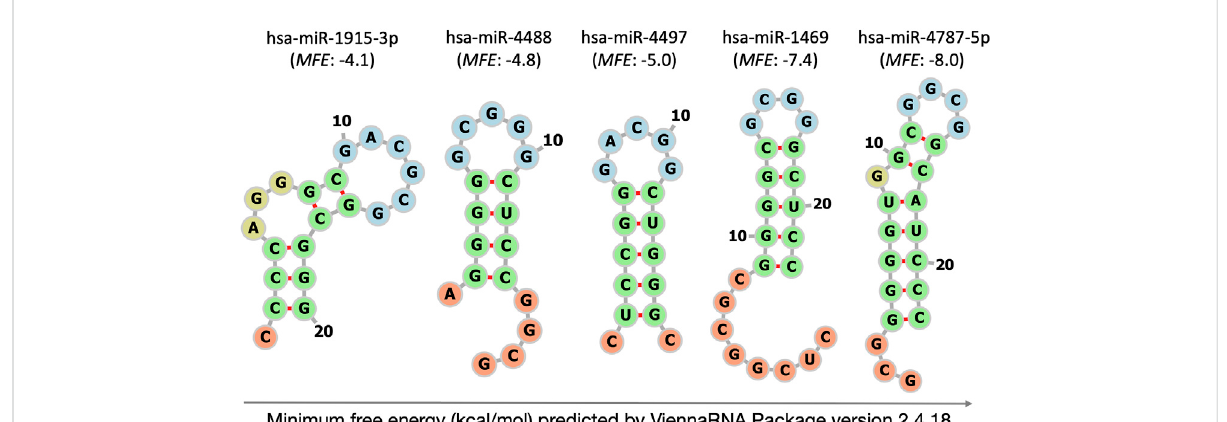
FIGURE 2 Self-complementarity of extremely GC-rich mature miRNAs at 37 ° C predicted by ViennaRNA Package version 2.4.18. The illustration of intramolecular hybridisation is limited to the fi ve microarray-selected miRNAs with most negative Δ G values. MFE : minimum free energy (kcal/mol). Structural details depicted by colour are loop (blue), stem (green), single-stranded tail (orange) and bulge or internal loop (olive).